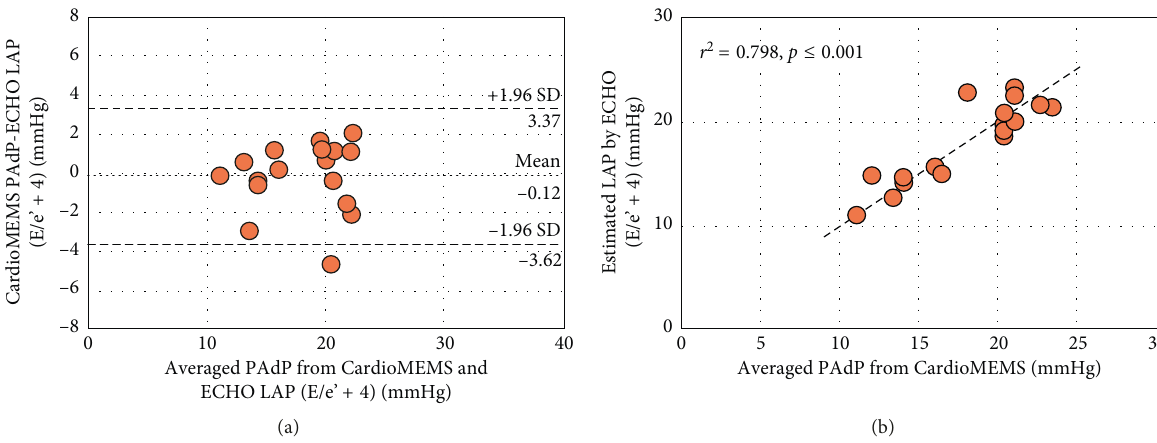
Figure 1: Bland–Altman analysis (a) and linear correlation (b) between CardioMEMS-derived pulmonary artery diastolic pressure (PAdP) and echocardiography-estimated left atrial pressure (LAP) by Nagueh formula (estimated LAP � 1.24 × ( E / e ’)+1.9).